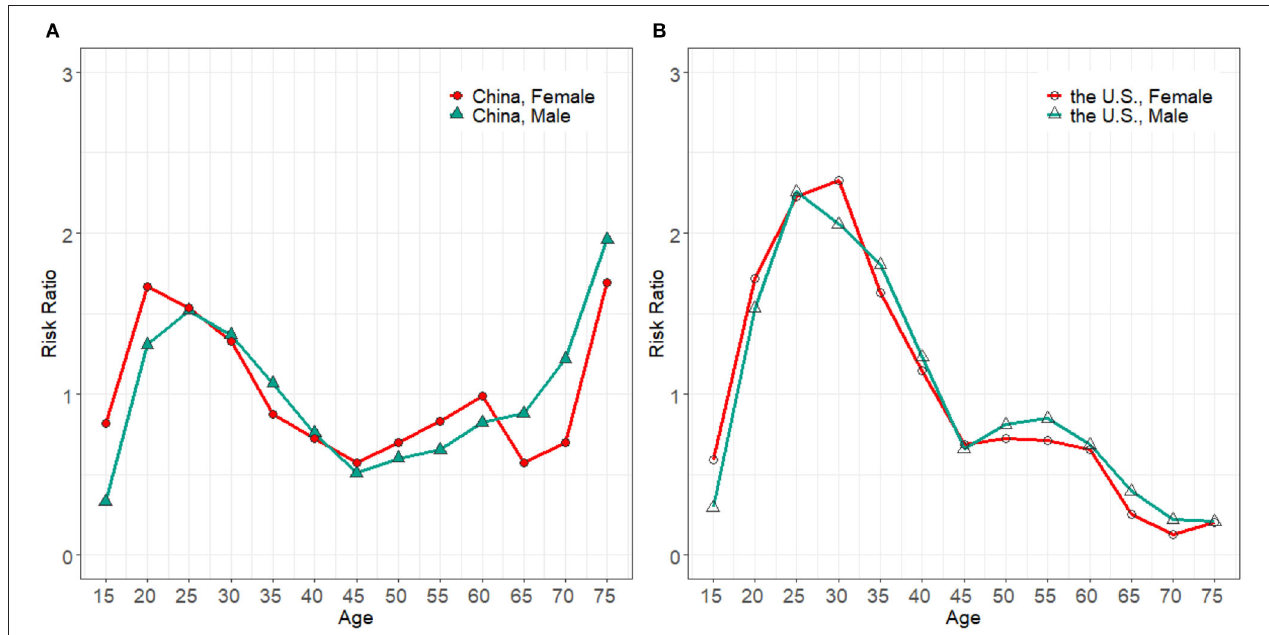
FIGURE 3 | Age effect on HIV/AIDS incidence for males and females in China (A) and the U.S. (B) , from 1994 to 2019.